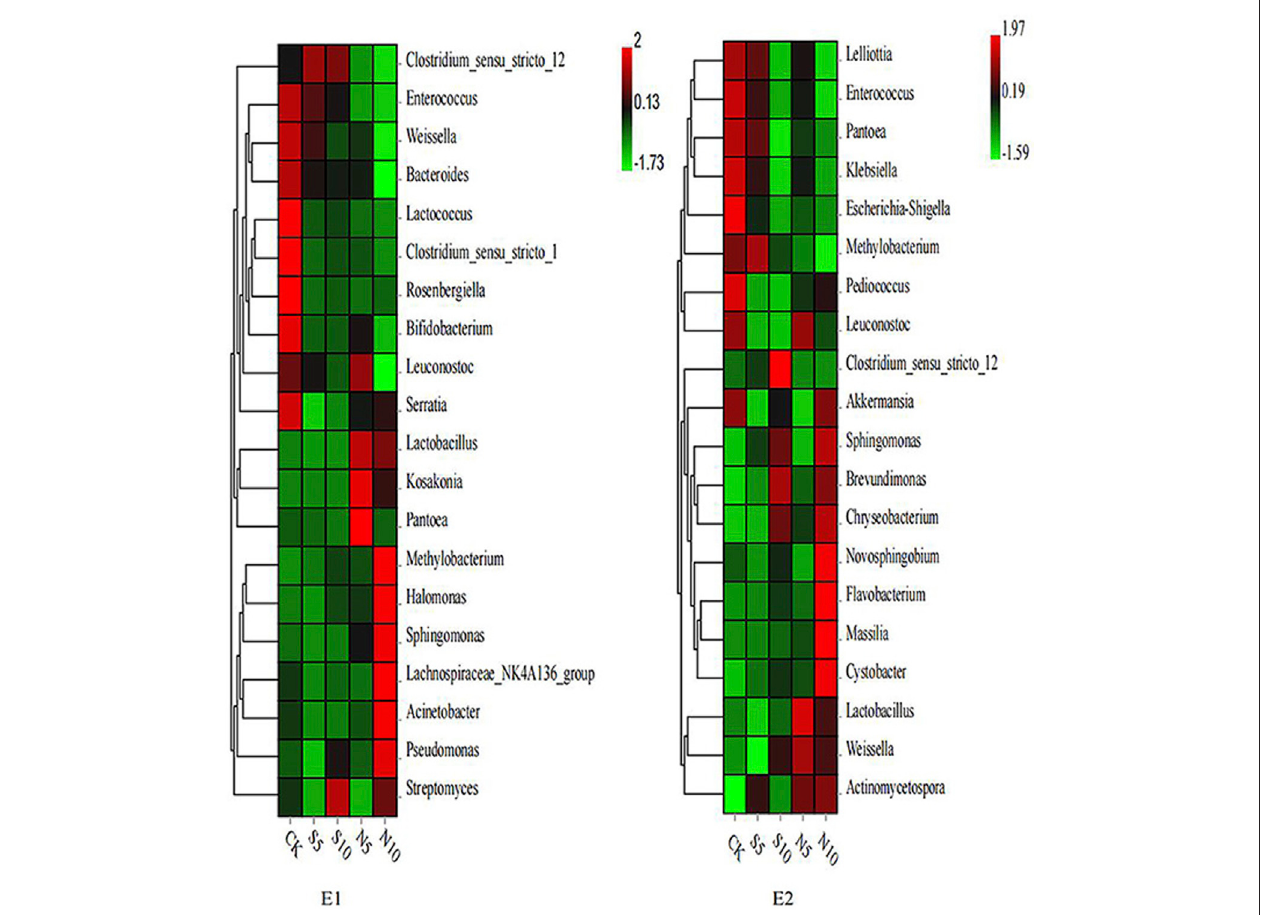
FIGURE 3 | Heatmap of bacterial communities at the genus level of stylo silage mixed with stylo meal and N. cadamba leaf meal (E1 and E2, experiments 1 and 2; CK, control; S5 and S10, mixed with 5% and 10% stylo meal; N5 and N10, mixed with 5% and 10% N. cadamba leaf meal).